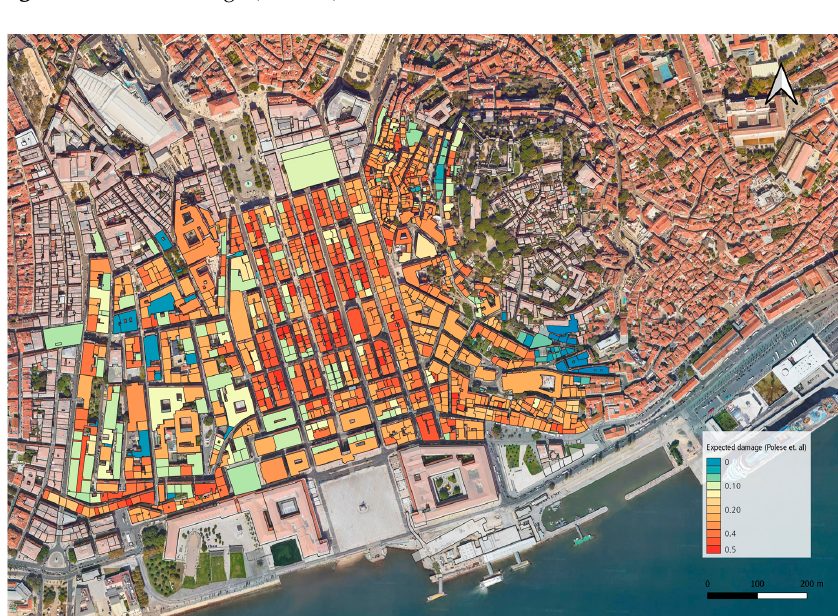
Figure 13. Mean damage (Polese et al. method).